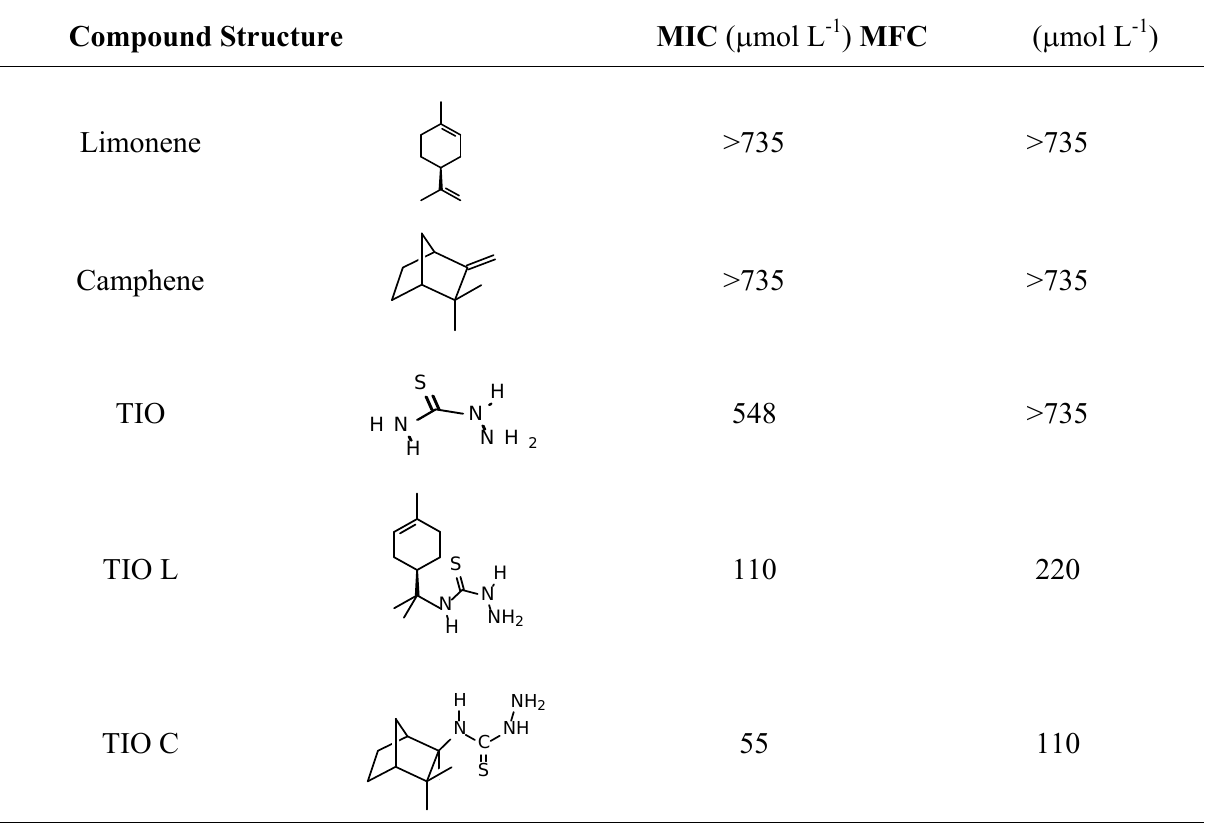
Table 1 . Chemical structure and Minimal Inhibitory Concentrations (MIC) and Minimal Fungicidal Concentrations (MFC) of camphene, limonene, and the thiosemicarbazides TIO, TIO C, and TIO L against T.